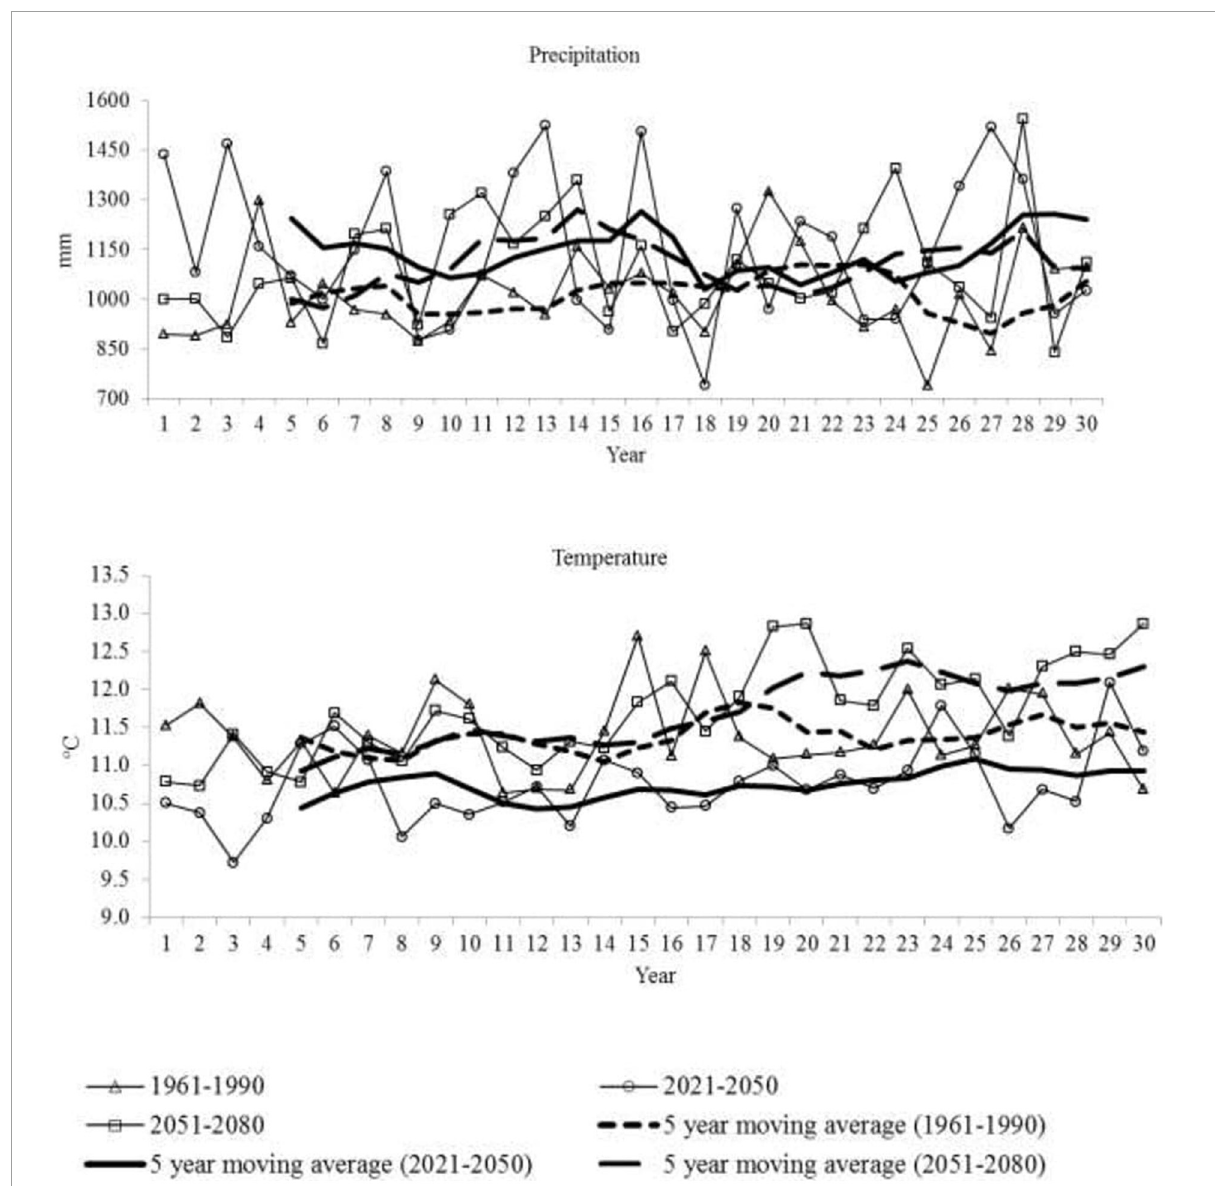
FIGURE3 Annual precipitation (mm) and annual mean temperature ( ◦ C) simulated with the CliPick tool (Palma, 2017) for the scenarios of climate 1961–1990, 2021–2050, and